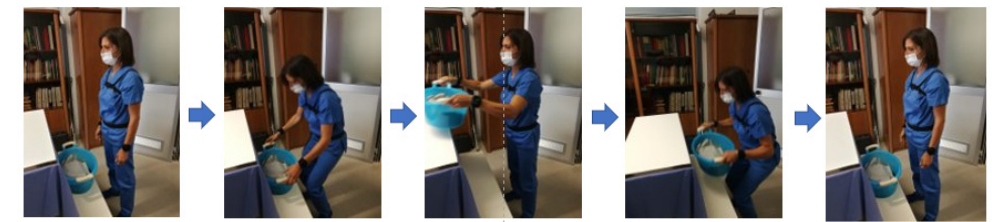
Figure 3. Phases of the lifting tasks: initial rest position, lifting weight with squatting technique upwards, upper destination point, lifting weight with squatting technique downwards, lower destination point and rest position.